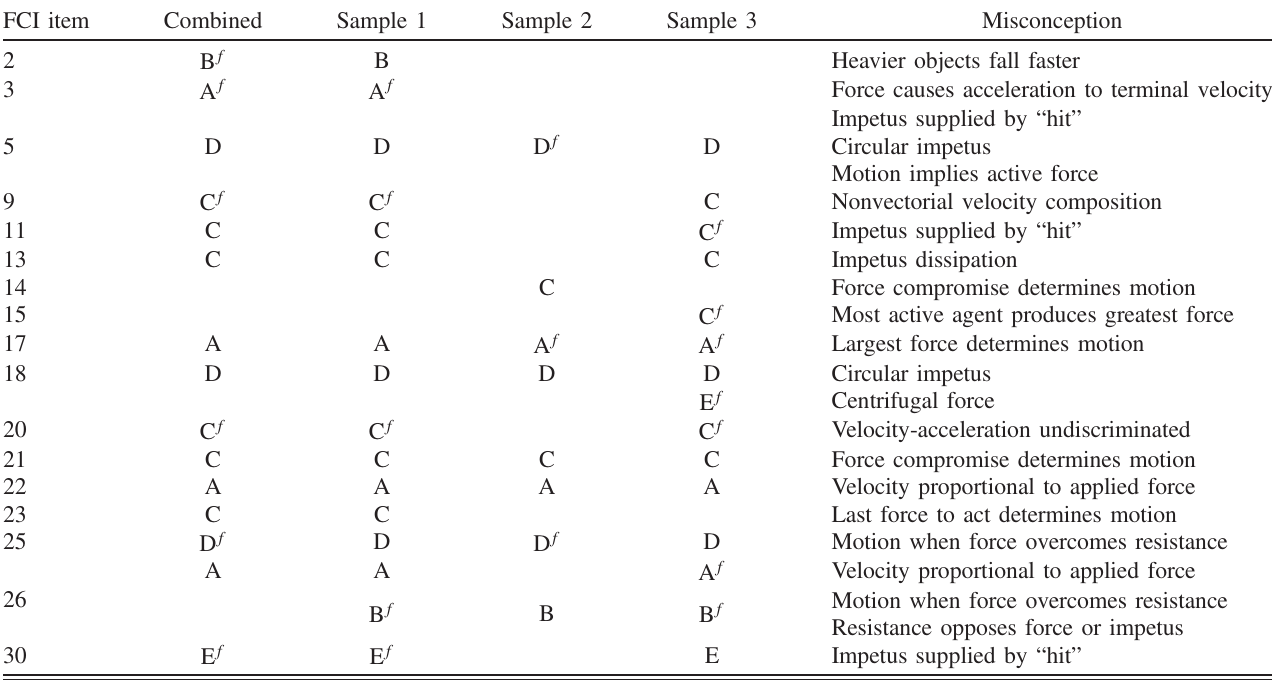
TABLE I. Intermediate maximum IRC curves. Responses labeled with a superscript f are flat over an extended range, other items reach a maximum before